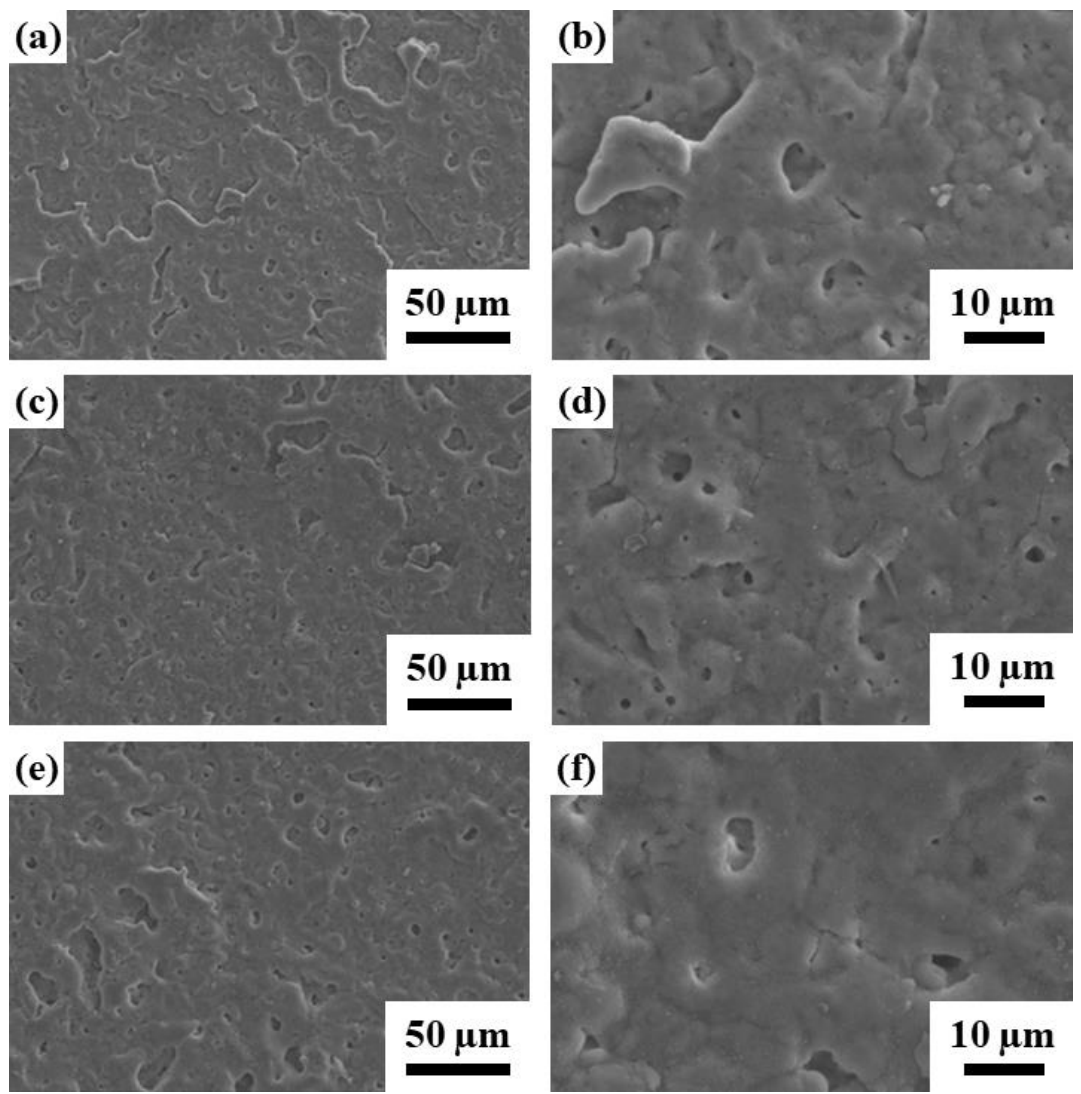
Figure 2. SEM morphology of the AZ31 sample treated in the EDTA ( a , b ) 2.5 g; ( c , d ) 5.0 g; and ( e , f ) 7.5 g bath. Table 2. EDS analysis of the different Ca-P containing MAO samples on AZ31 Mg alloys